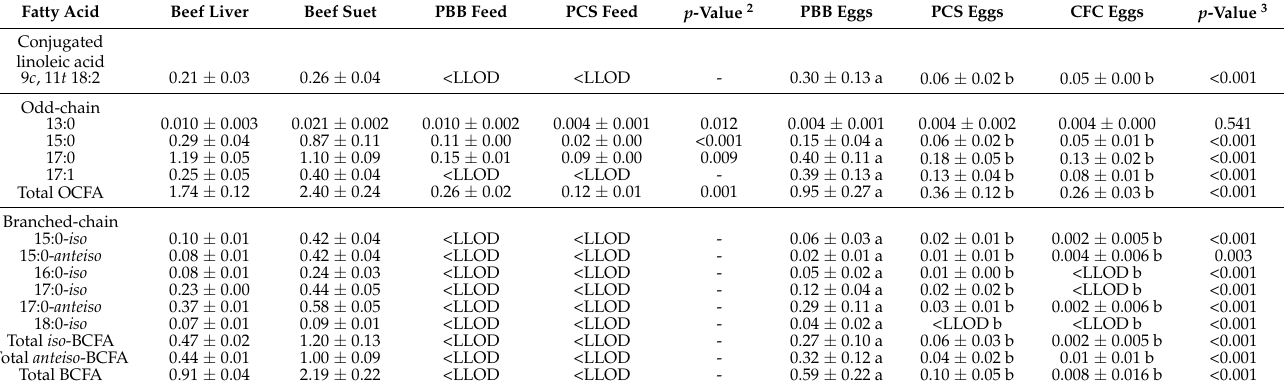
Table 6. Conjugated linoleic acid, odd-chain fatty acid, and branched-chain fatty acid content of grass-fed beef by-products, layer hen feeds, and egg yolks (% of total fatty acids) 1 . PBB Feed PCS Feed p -Value